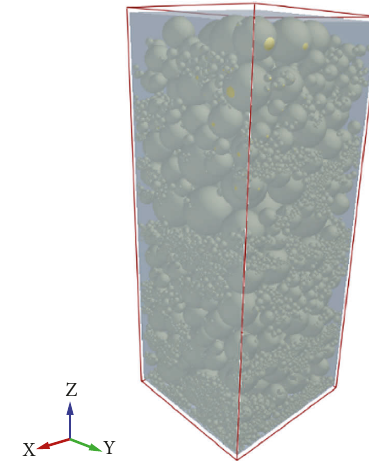
Figure 2: Sandstone model generated by EDEM.